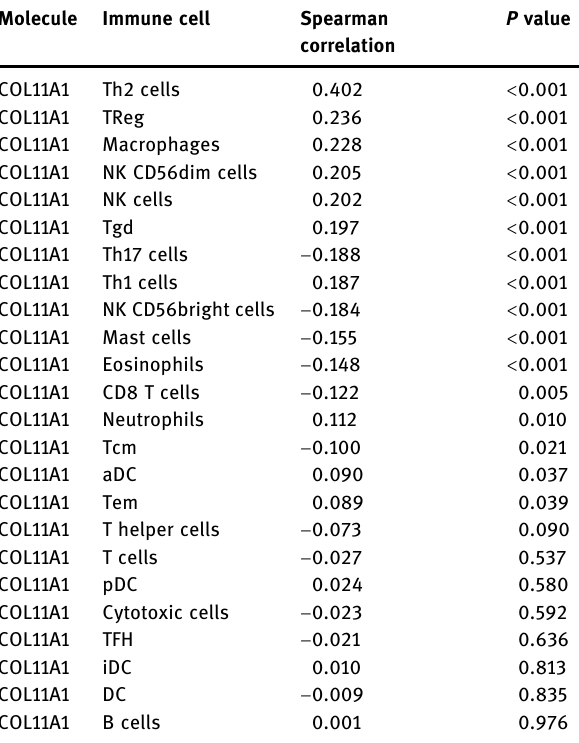
Table 1: Relationship between COL11A1 and immune cell enrichment in LUAD Molecule Immune